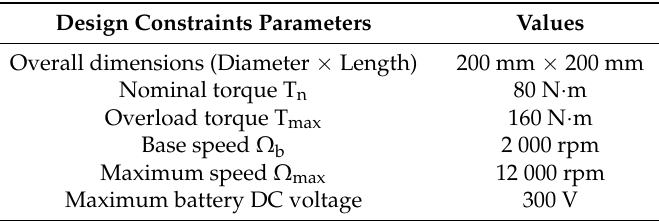
Table 1. Design constraints.